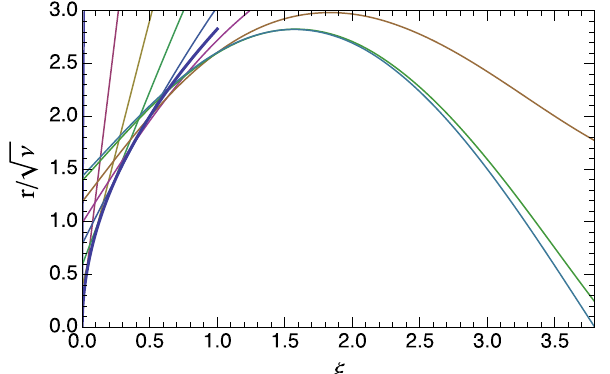
FIG. 3. A small number of selected trajectories showing a transition from an envelope bubble boundary to a single trajec- tory. The thick blue line shows the ballistic approximation, Eq. (15), for the